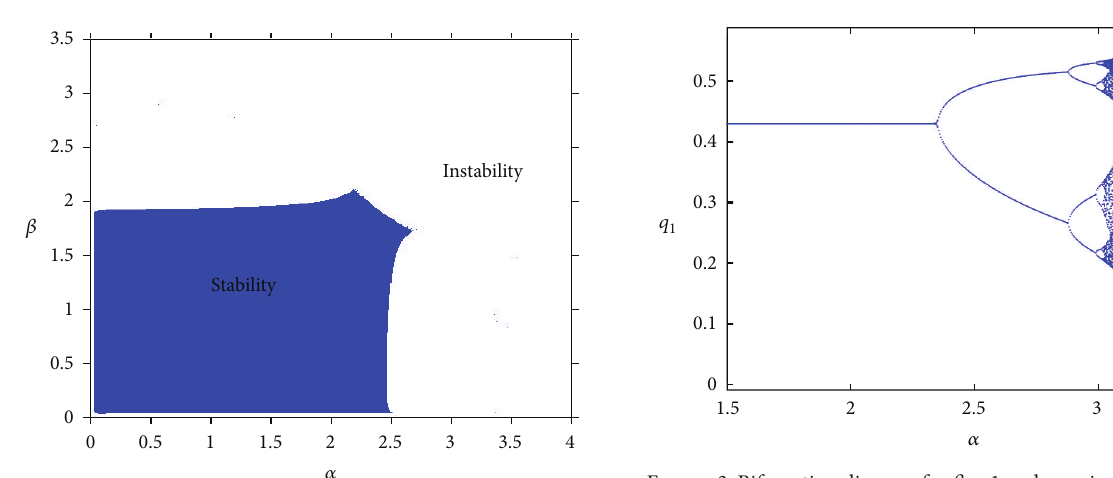
Figure 3: Bifurcation diagram for 𝛽 = 1 and 𝛼 varies from 1.5 to 3.5.